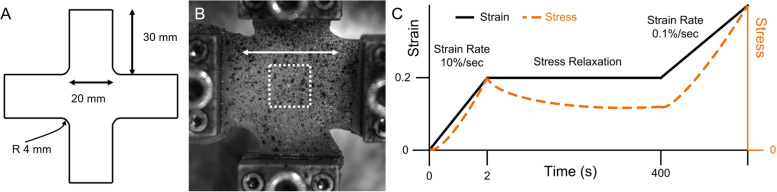
Planar biaxial materials testing overview, with (A) cruciform geometry, (B) representative planar biaxial sample, where the white arrow denotes the longitudinal direction and the white dashed square denotes approximate DIC region of interest (ROI), and (C) experimental stress-relaxation loading protocol schematic (note that axes are not to scale).